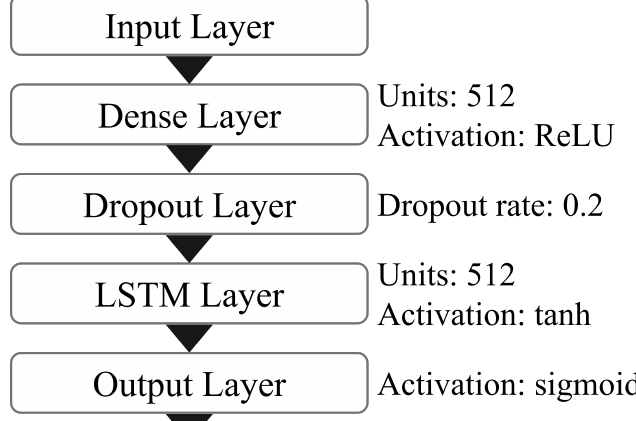
Figure 10. Long short-term memory (LSTM) network